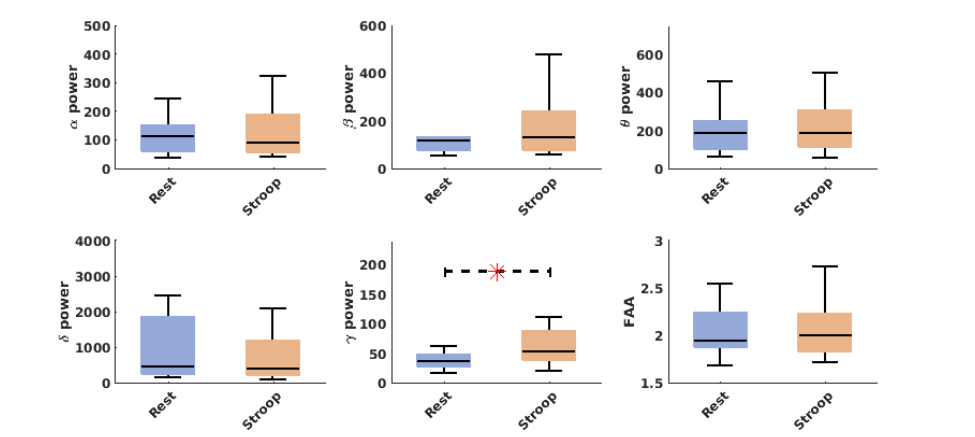
Figure 7. Results from the Wilcoxon sign-rank test considering the EEG-derived features. Statistically significant comparisons resulting in p < 0.05 are highlighted with